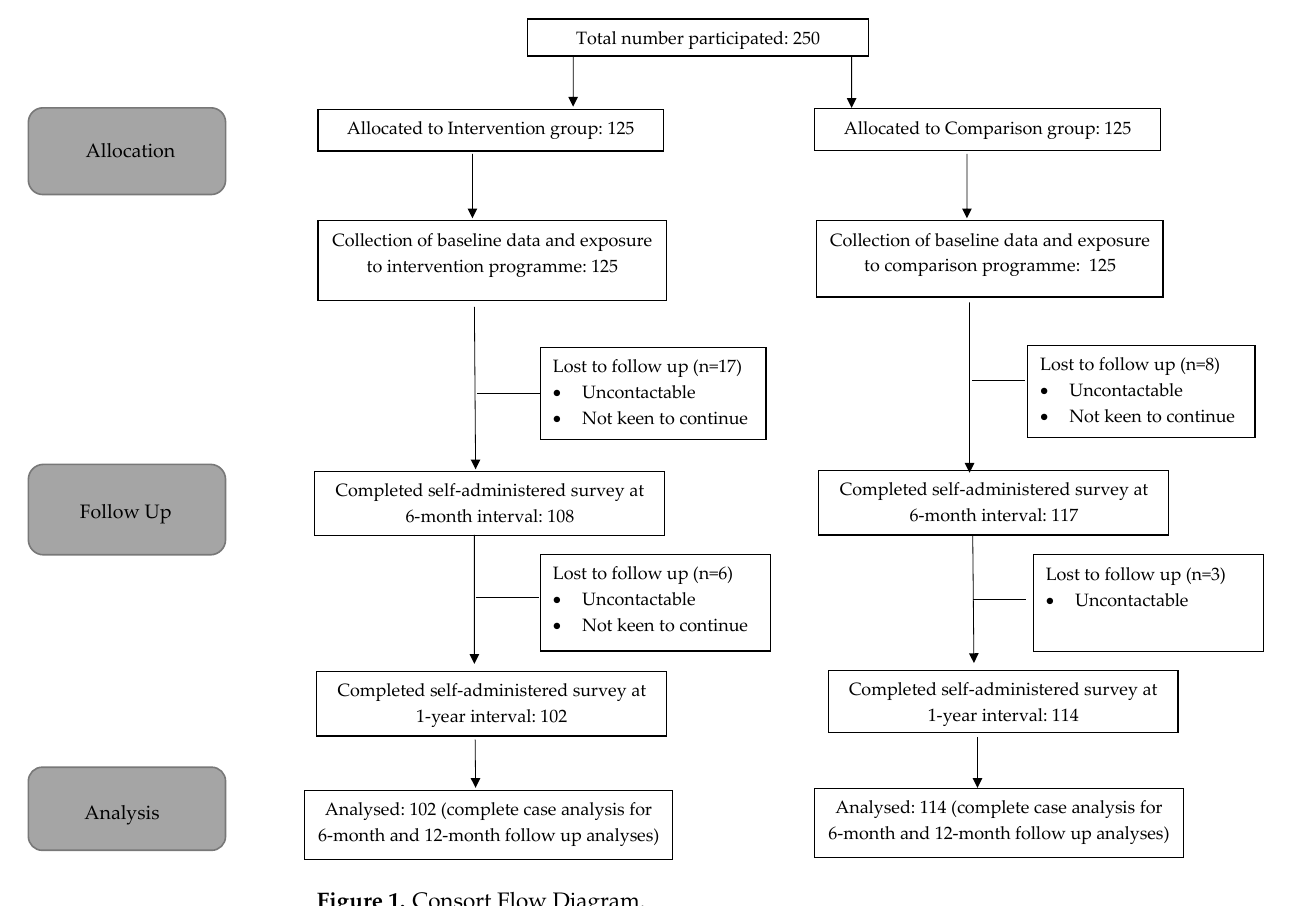
Figure 1: Consort Flow Diagram